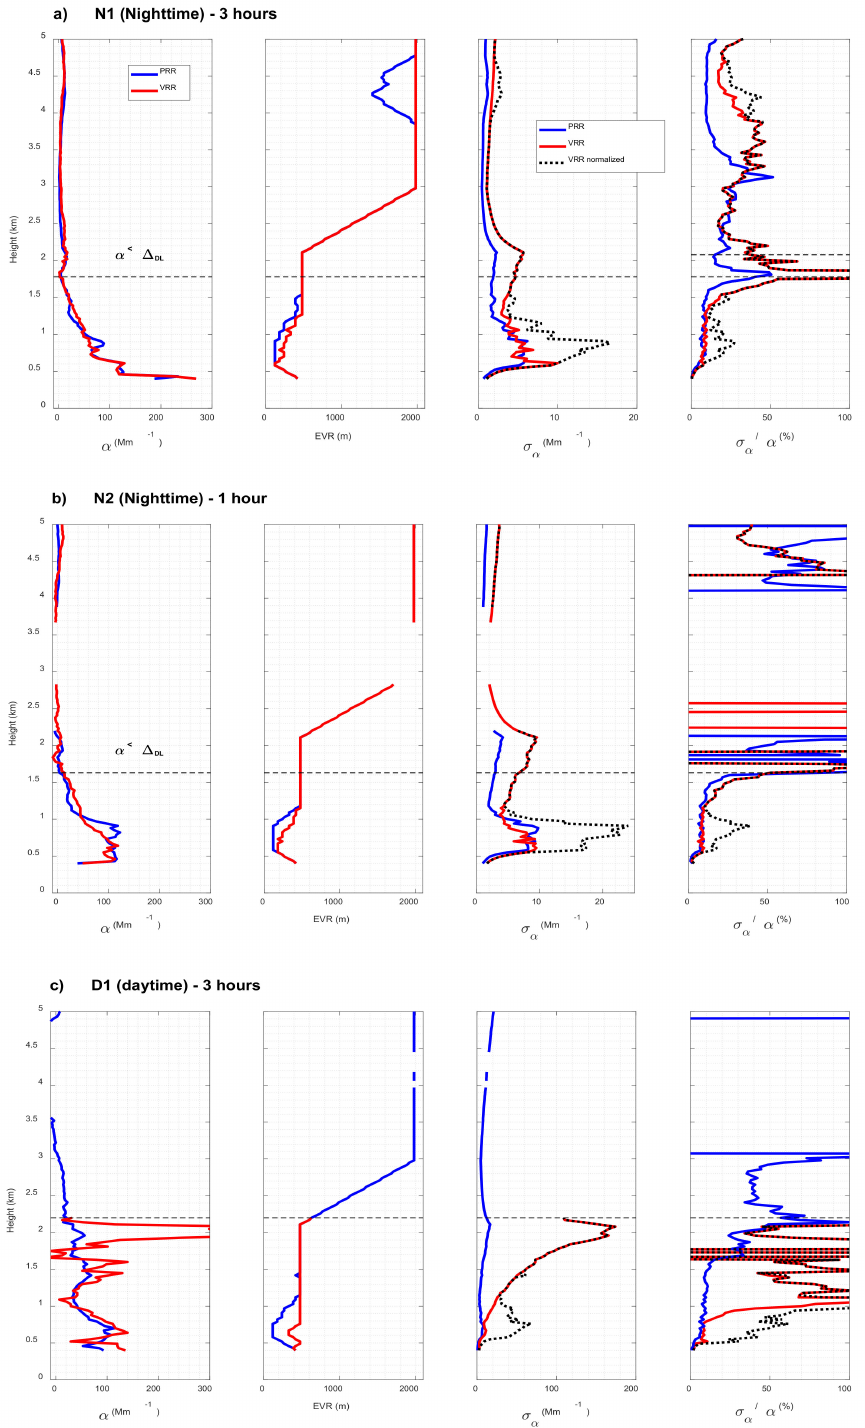
Figure 9. Aerosol extinction coefficient, vertical resolution, absolute and relative errors retrieved by the SCC from PRR and VRR signals for case ( a ) N1, ( b ) N2 and ( c ) D1. In ( a , b ) the black horizontal dashed lines represent the lowest height for which α < ∆ DL . In ( c ) it represents the highest height for which α |VRR is retrieved. “VRR normalized” refers to the magnitude recalculated at or normalized to EVR |PRR . The legends in Figure 9a apply to all